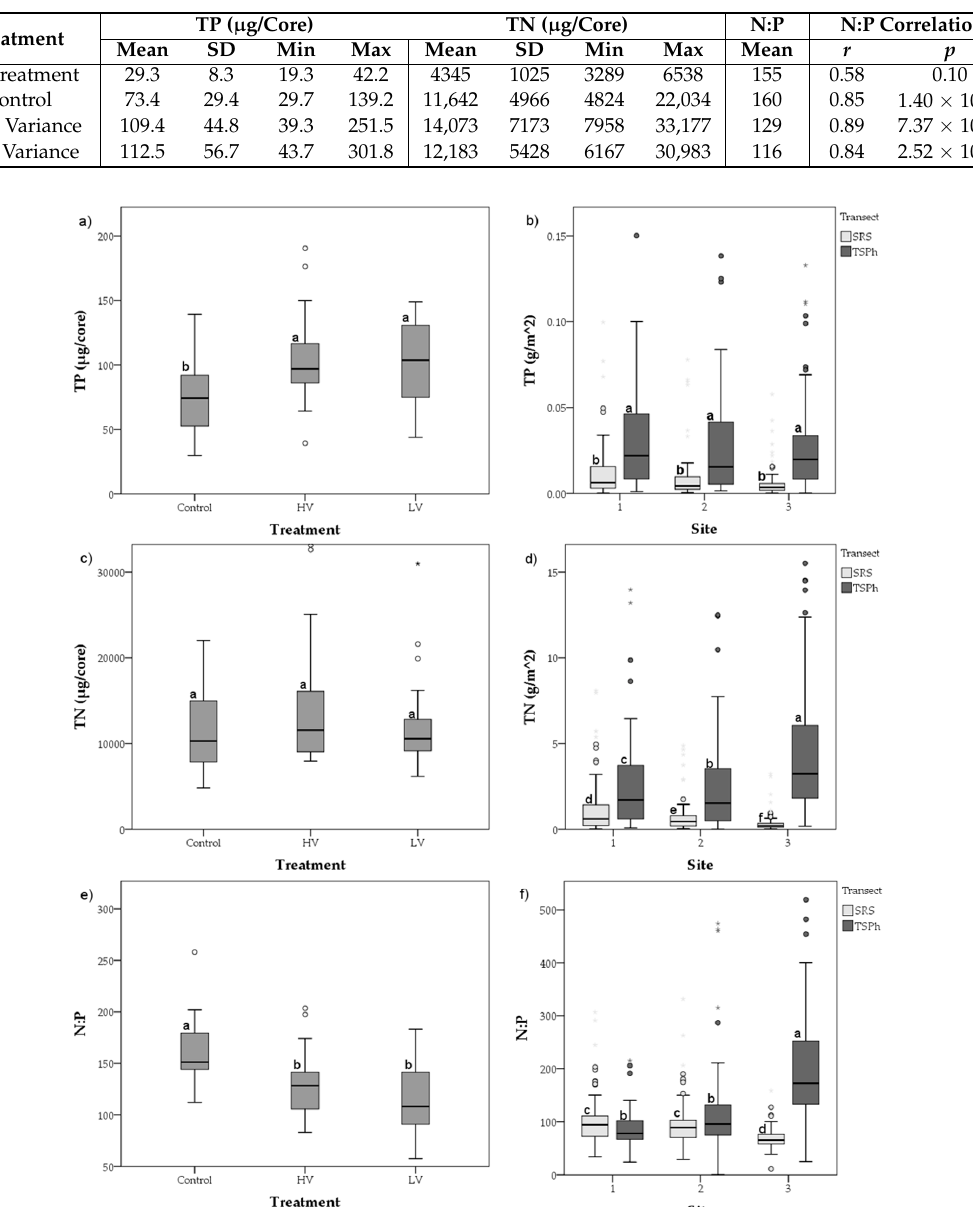
Figure 3. Spatial trends of: ( a ) mean mat total phosphorus (TP, g/m 2 ) in SRS and TS/Ph; ( b ) mean TP (µg/core) in the experimentally treated mats; ( c ) mean mat total nitrogen (TN, g/m 2 ) in SRS and TS/Ph; ( d ) mean TN (µg/core) per treatment; ( e ) mean N:P in SRS and TS/Ph; ( f ) mean N:P molar ratio per treatment. Significant differences (Long-term: Games-Howell; Experiment: Tukey’s HSD; p < 0.05) are indicated by different letters. Site 1 refers to SRS 1d and TS/Ph 1b. Note the different axis units. Site number increases downstream. Site name abbreviations as in Figure 1.